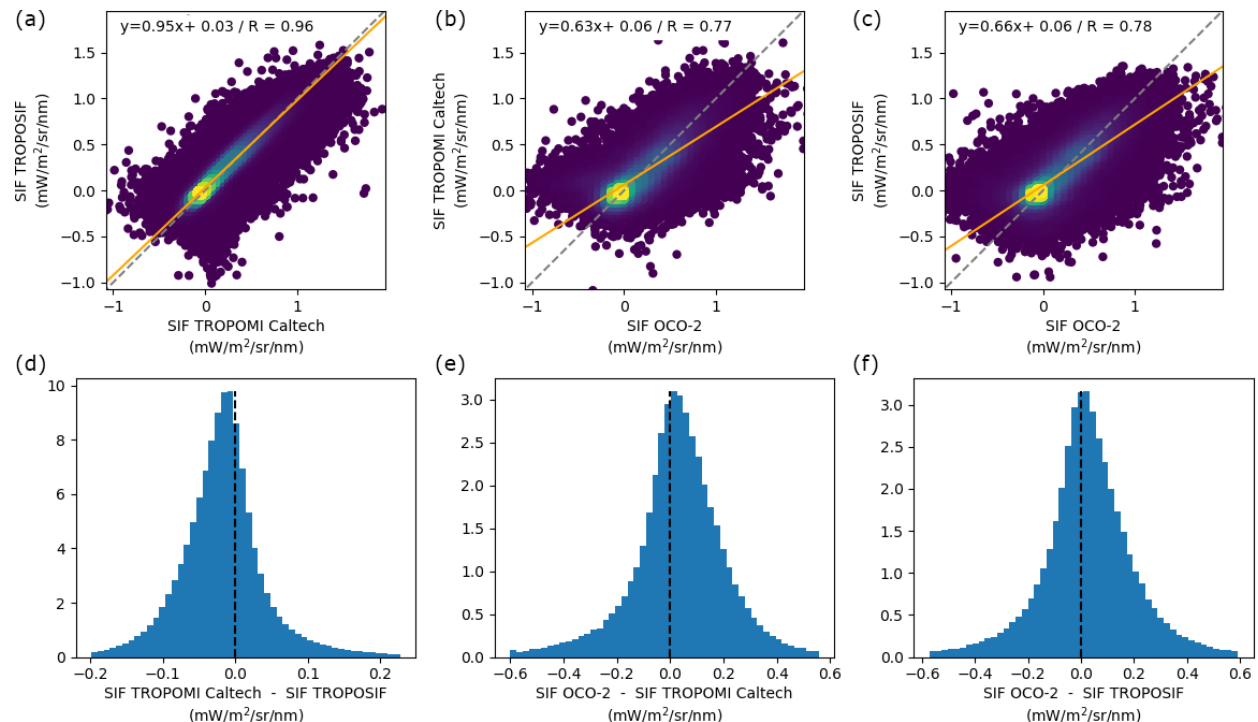
Figure 9. Scatterplots (a–c) and histograms (d–f) of the difference between each pair of SIF datasets, namely TROPOSIF (743–758nm window), Caltech TROPOMI, and OCO-2 for August 2019 (daily/0.1 ◦ data, CF < 0.2). The linear regression line between two datasets is shown in orange. The linear regression equations and the correlation coefficient R are provided. A day-length correction has been applied to all three datasets.